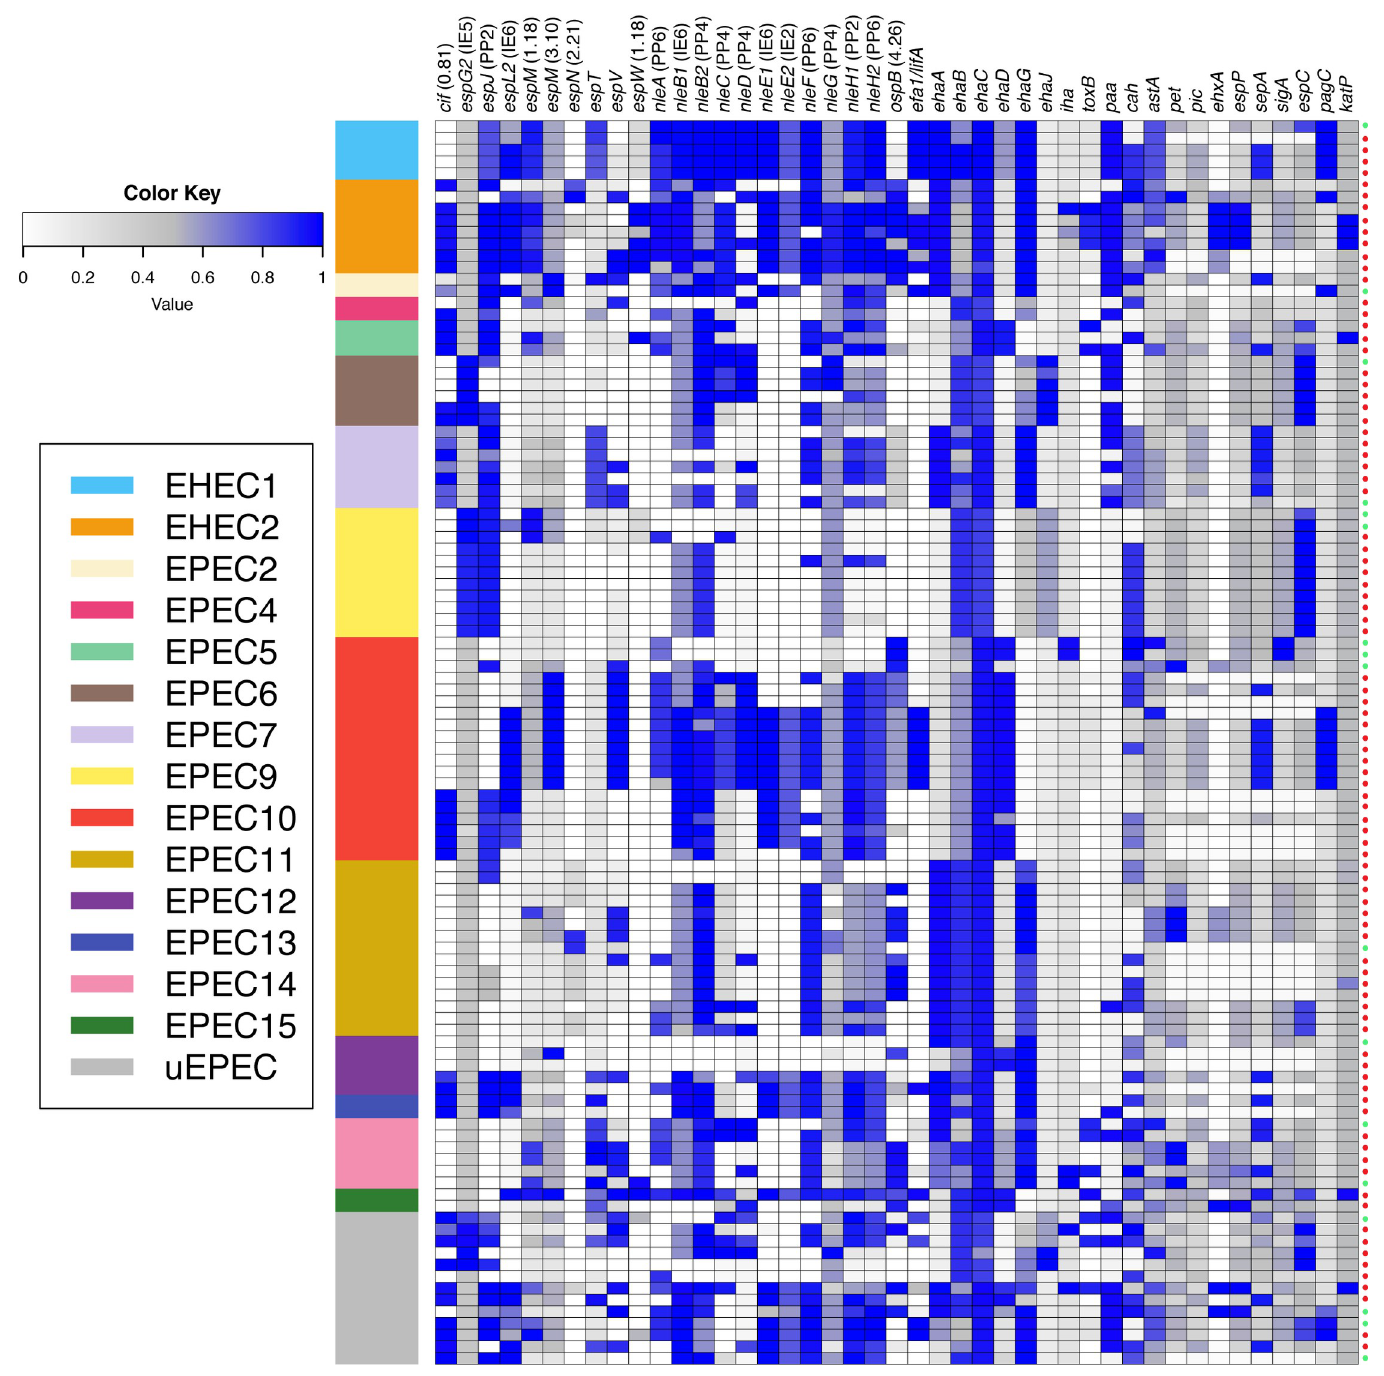
Fig 2. In silico detection of known EPEC virulence factor-encoding genes in the 106 Brazilian aEPEC genomes studied. The virulence factor-encoding genes were detected in each of the 106 Brazilian aEPEC genomes analyzed in this study using large-scale BLAST score ratio (LS-BSR) analysis. Each row is a different aEPEC genome, grouped by phylogenomic lineage, and each column represents a single gene (listed in the S7 Table). The presence or absence of all predicted protein-encoding genes in the 106 Brazilian aEPEC genomes is indicated by the BSR values represented in the heatmap generated by using the heatmap2 function of gplots v.3.0.1 in R v.3.3.2. Colors of the heat map indicate virulence genes that were detected with significant similarity (blue), with divergent similarity (gray) or were absent (white) in each of the Brazilian aEPEC genomes analyzed. On the far right red circles indicate aEPEC isolates obtained from patients with diarrhea, while green circles indicate aEPEC isolates obtained from healthy